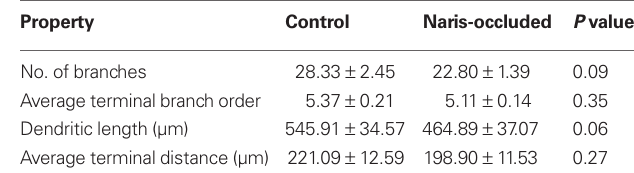
Table 2 | Apical dendrite properties – control vs. naris-occluded. Table 1 | Apical dendrite properties – control vs. sirNA knock-down.